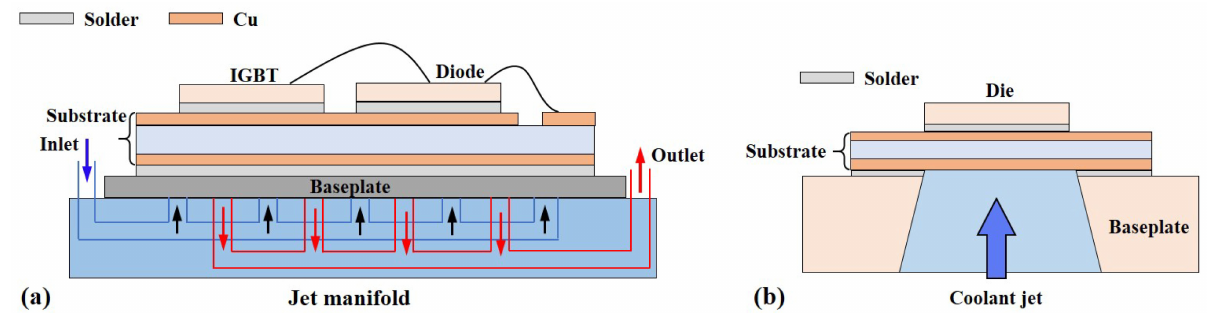
Figure 10. Schematic of ( a ) the power module with multijet impingement cooling and ( b ) the direct backside jet impingement cooling